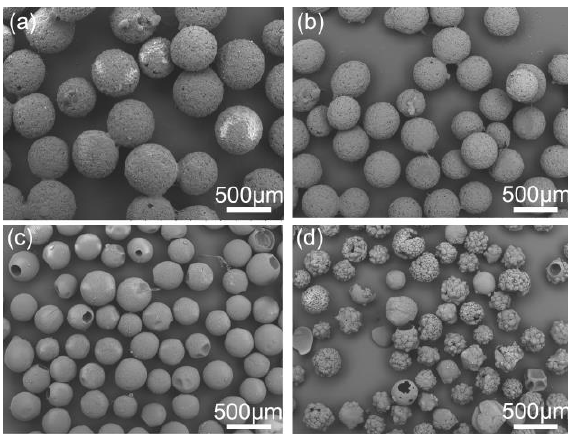
Figure 14. SEM images of the spherical crystals prepared at different concentrations of substance: ( a ) 0.7 g/mL, QESD-13; ( b ) 0.5 g/mL, QESD-14; ( c ) 0.4 g/mL, QESD-2; ( d ) 0.2 g/mL, QESD-16.